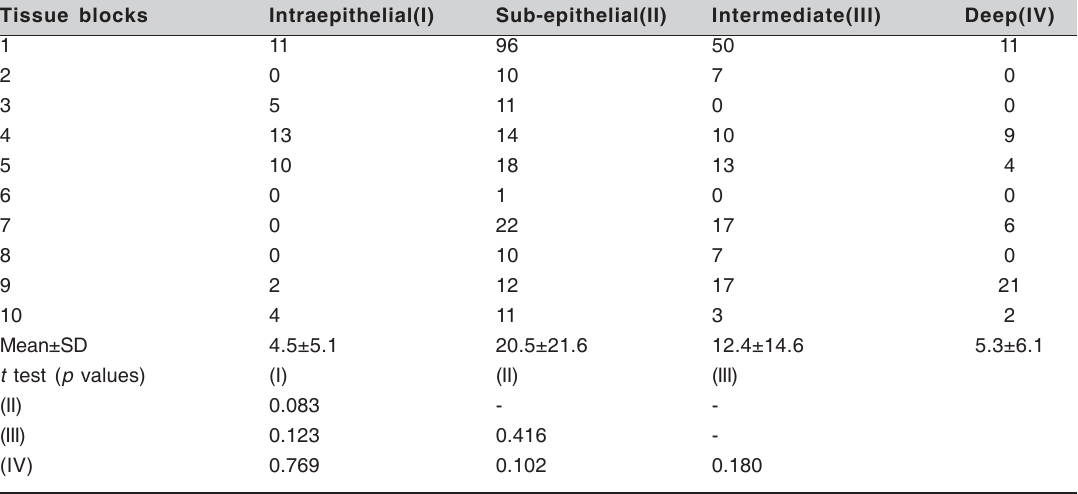
of t test between zones)